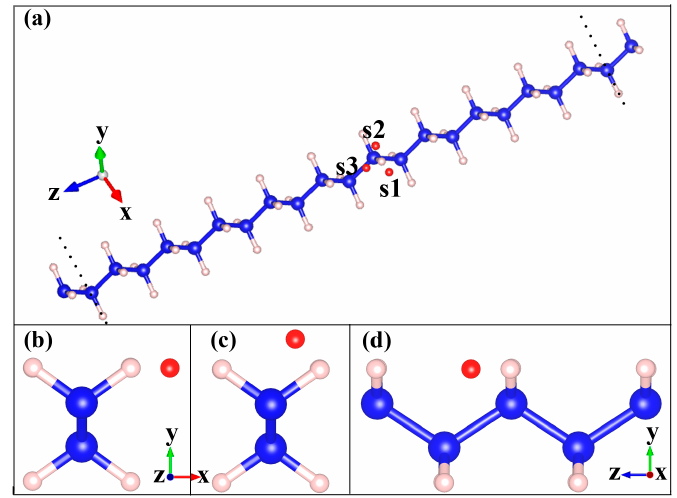
Figure 1. (Color online) ( a ) Stereogram of an infinitely long hydrocarbon chain with one H atom adsorbed at different sites. The two dotted lines show the borders of the supercell along the z direction. ( b – d ) are enlarged views of the adsorption sites of s1, s2, and s3, respectively. The blue, pink, and red balls denote the carbon, hydrogen, and the adsorbed H or H 2 , respectively.